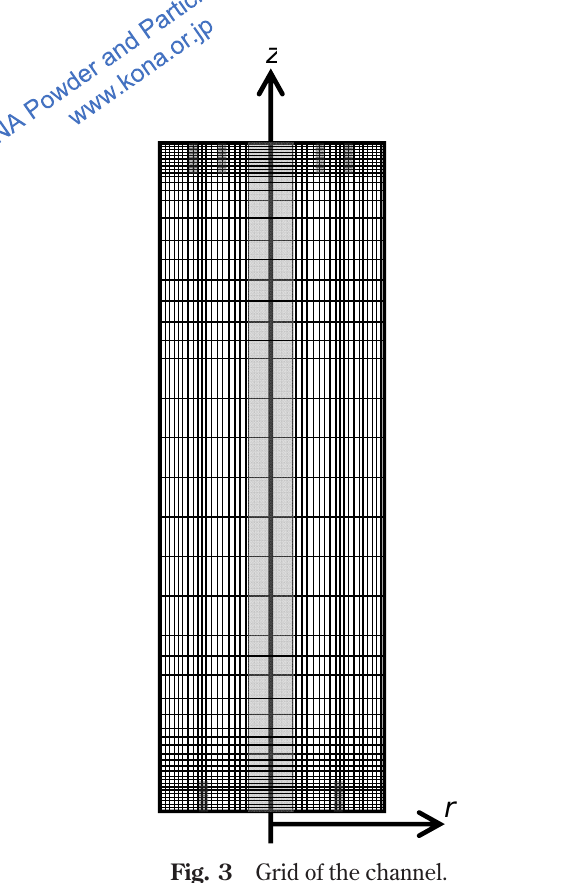
Fig. 3 Grid of the channel.